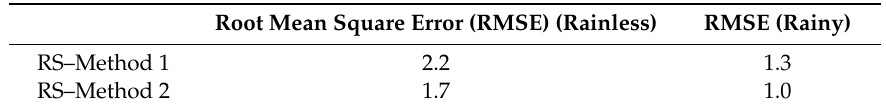
Figure 8. Statistics of the root mean square error (RMSE) di ff erences for RS–Method 1 and RS–Method 2 at 00:00 and 12:00 UTC in the period of DOY 182–184, 2019, and DOY 244–246, 2019. Table 3. Statistics of the tomography accuracy with respect to the RS method during a rainless period and a rainy period (g / m 3